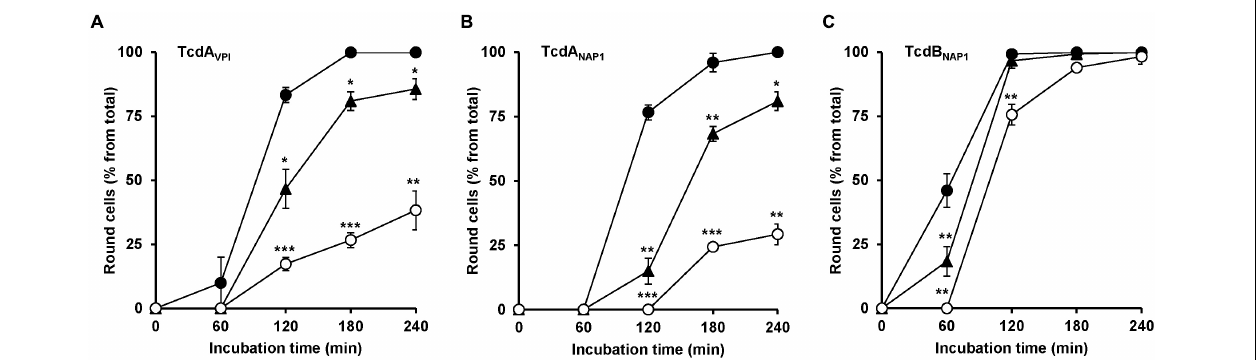
FIGURE 6 | Effect of U18666A on the intoxication of HeLa cells by TcdA VPI , TcdA NAP1 and TcdB NAP1 . HeLa cells preincubated with increasing concentrations of U18666A (0 µ M, black filled circles; 1.25 µ M, black filled triangles and 10 µ M, white filled circles) were intoxicated with (A) 10 pM VPI-derived TcdA (TcdA VPI ), (B) 10 pM NAP1/027-derived TcdA (TcdA NAP1 ) or (C) 1 pM NAP1/027-derived TcdB (TcdB NAP1 ), prior to microscopic analysis of the cell morphology over time. Graphs in (A–C) show means (percentage values of round cells) from three experiments performed in parallel in independent wells. Error bars represent ± SD. Asterisks indicate statistical significance compared to control (mock-treated HeLa cells) with * p < 0.05, ** p < 0.01, and *** p <